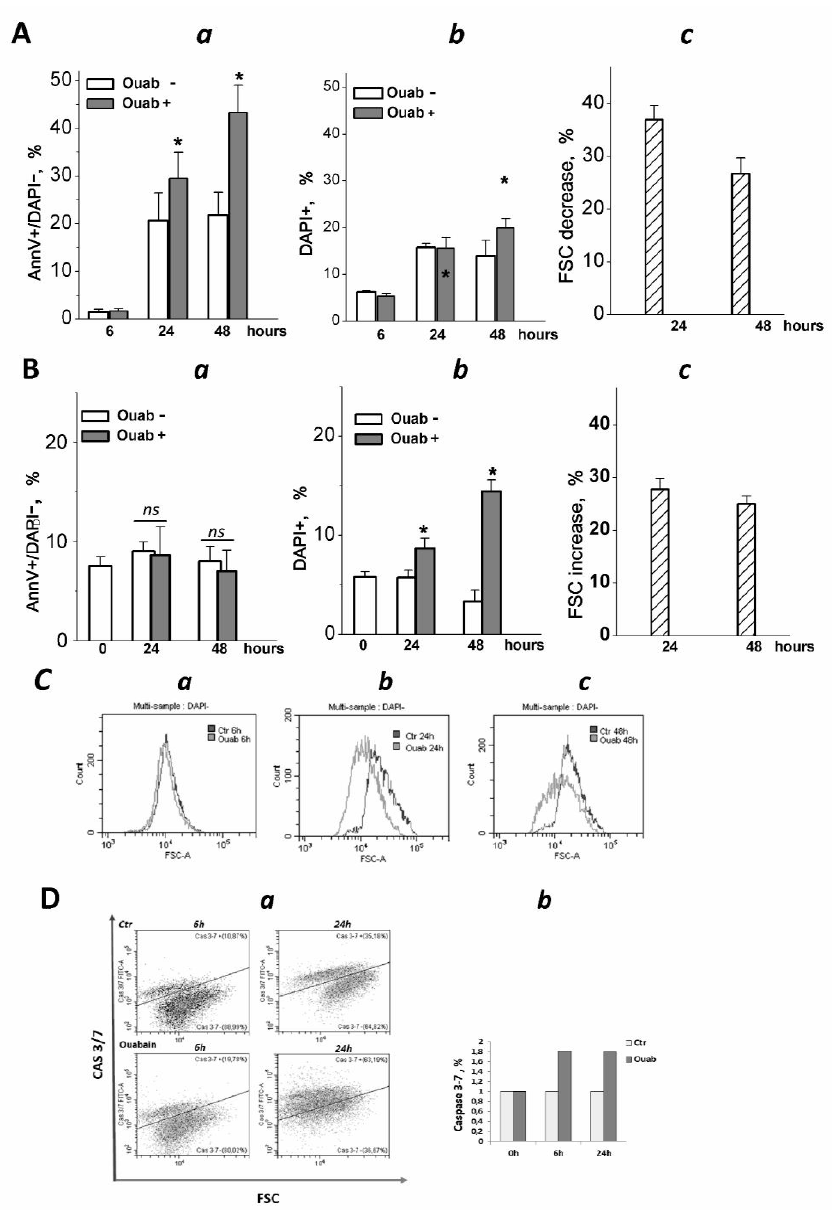
Figure 3. Three-dimensional eMSCs activate the apoptotic program in response to ouabain. ( A , B ) Quantification of apoptotic cell fractions in 2D and 3D eMSCs exposed to 1 µM ouabain; a —early apoptotic An+/DAPI- cell fraction; b — dead DAPI+ cell fraction; c —FSC decrease in ouabain-treated 3D eMSCs ( A ) and FSC increase in ouabain-treated 2D eMSCs ( B ), % to FSC of ouabain-untreated